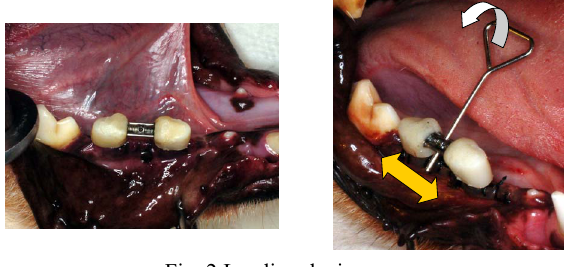
Fig. 2 Loading device. Acrylic resin crowns are connected with an orthodontic expansion screw. Rotation of 360 degree (white arrow) results in 0.7mm horizontal expansion (yellow arrow).